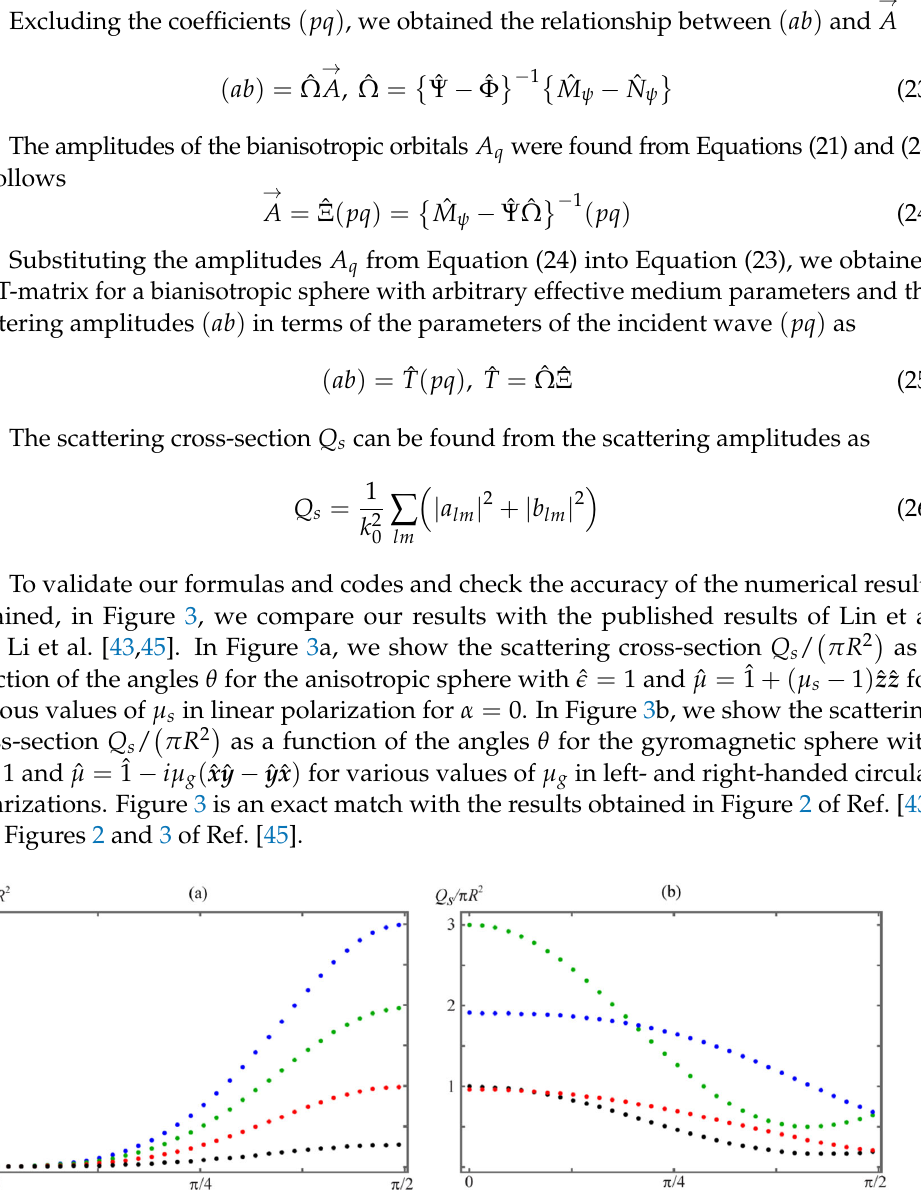
Figure 3. ( a ) Reduced scattering cross ‐ section 𝑄 (cid:3046) / (cid:4666)𝜋𝑅 (cid:2870) (cid:4667) for all angles 𝜃 in response to the linear polarization 𝛼 (cid:3404) 0 for an anisotropic sphere with the values 𝜇 (cid:3046) (cid:3404) 1.2 (black), 1.4 (red), 1.6 (green), 1.8 (blue), and 𝑥 (cid:3404) 𝑘 (cid:2868) 𝑅 (cid:3404) 4 . ( b ) Reduced scattering cross ‐ section 𝑄 (cid:3046) / (cid:4666)𝜋𝑅 (cid:2870) (cid:4667) for all angles 𝜃 for an anisotropic sphere with 𝜇 (cid:3034) (cid:3404) 0.4 (black—LCP, red—RCP), 0.8 (green—LCP, blue—RCP), and 𝑥 (cid:3404) 𝑘 (cid:2868) 𝑅 (cid:3404) 4 .